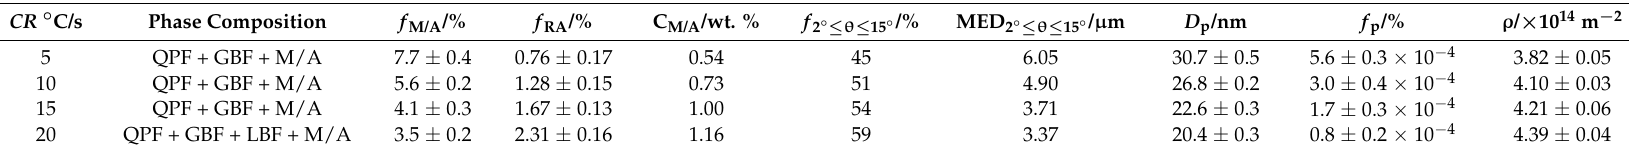
Table 3. Summary of microstructure observations and